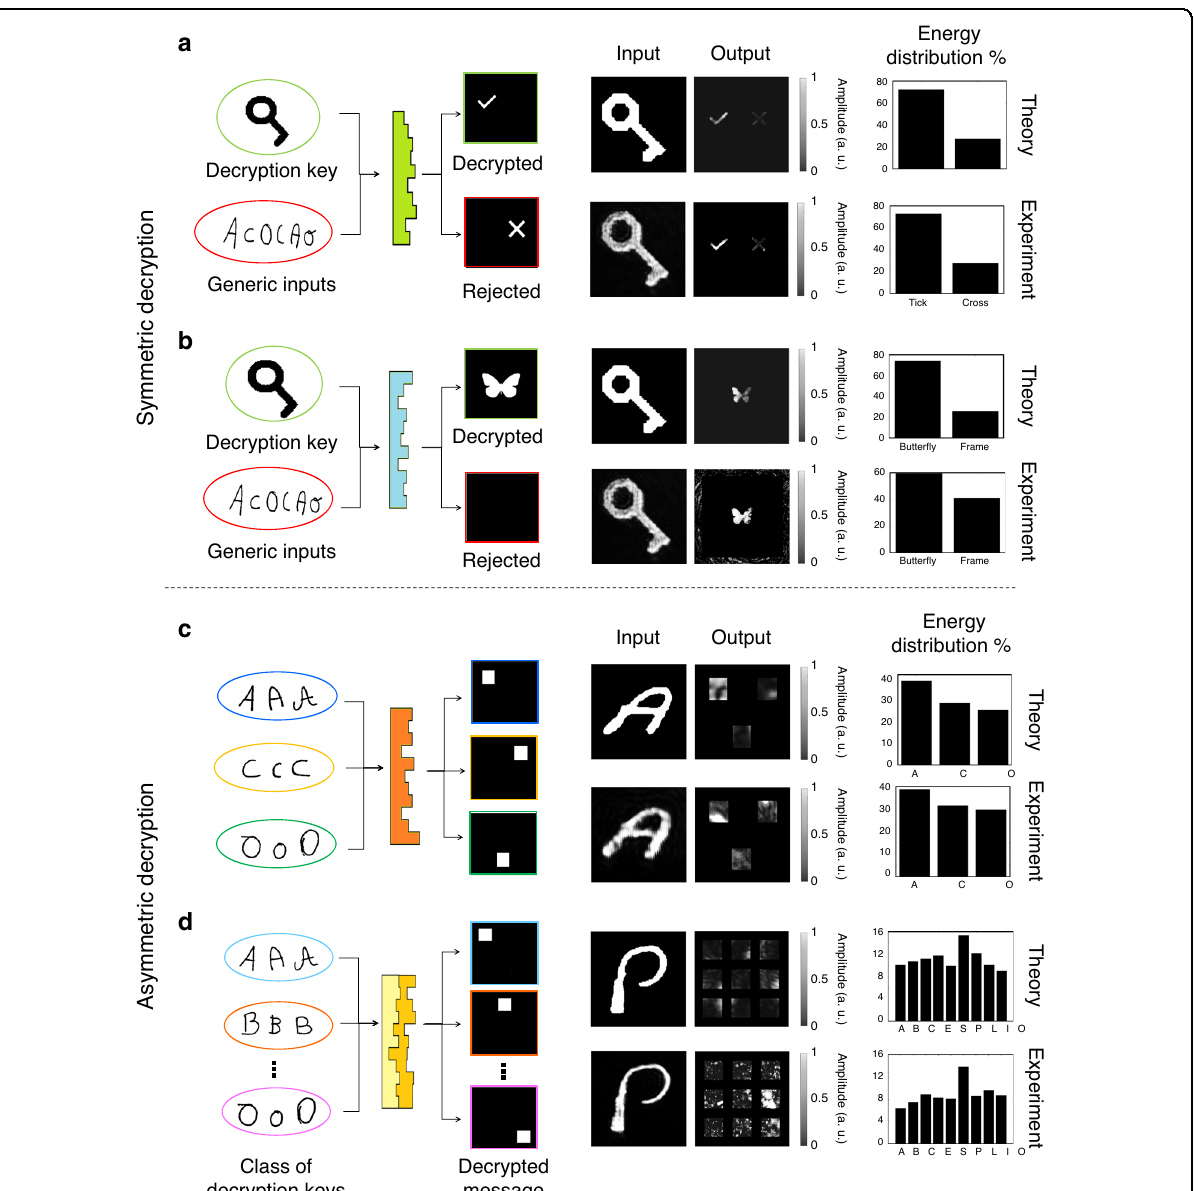
Fig. 4 Experimental veri fi cation of the MLD performance through optical inference. Schematic of the machine learning decryption function implemented, examples of the theoretical and experimental input fi elds, and corresponding output patterns and energy distribution percentages for MLD-T ( a ), MLD-B ( b ), 3-MLD ( c ) and 9-MLD ( d ). The complete results and performance analysis are reported in Figs. S19 – S23. The images of the input and output fi elds consist of 236 × 236 pixels (1.3 × 1.3 mm 2 ) in the case of 3-MLD, 274 × 274 pixels (1.5 × 1.5 mm 2 ) in the case of 9-MLD and 340 × 340 pixels (1.88 × 1.88 mm 2 ) in the case of MLD-T and MLD-B. Each MLD output image was multiplied with the mask related to that speci fi c MLD